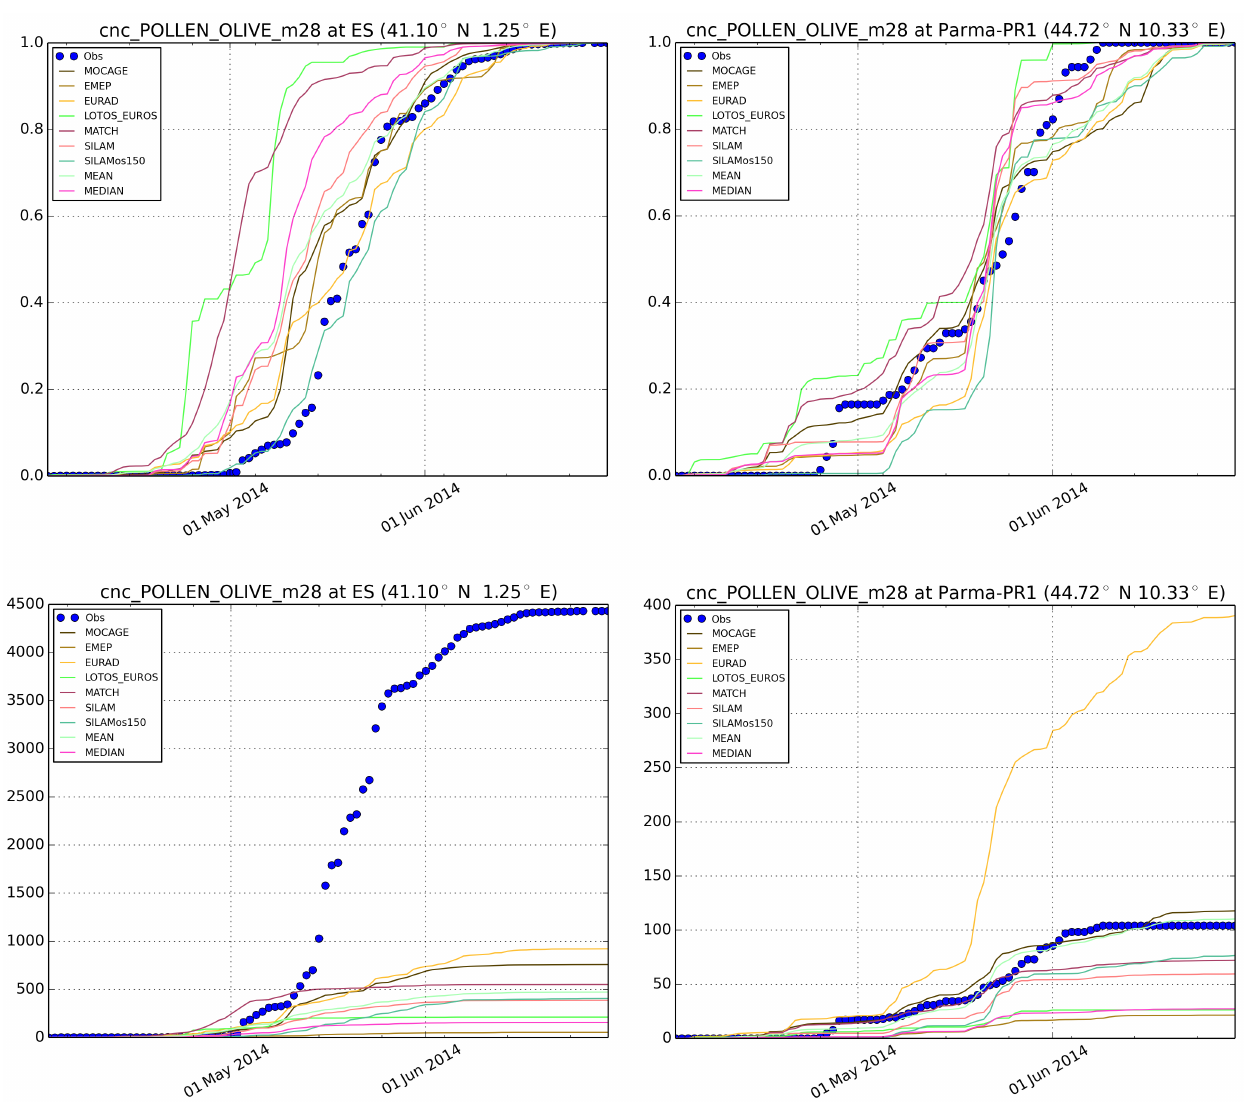
Figure 10. Cumulative time series of olive concentrations at Tarragona (Spain) and Parma (Italy). Upper row: normalised to the seasonal SPI [relative unit], lower row: absolute cumulative concentrations [pollen daym − 3